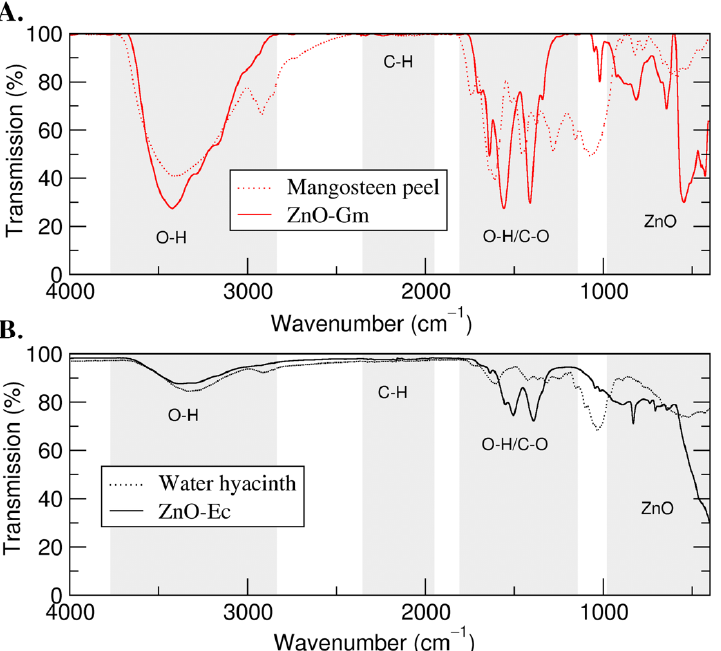
Figure 5. FTIR analysis of green synthesized ZnO NPs. ( A ) ZnO-Gm generated from mangosteen peel extract; ( B ) ZnO-Ec produced from water hyacinth extract.